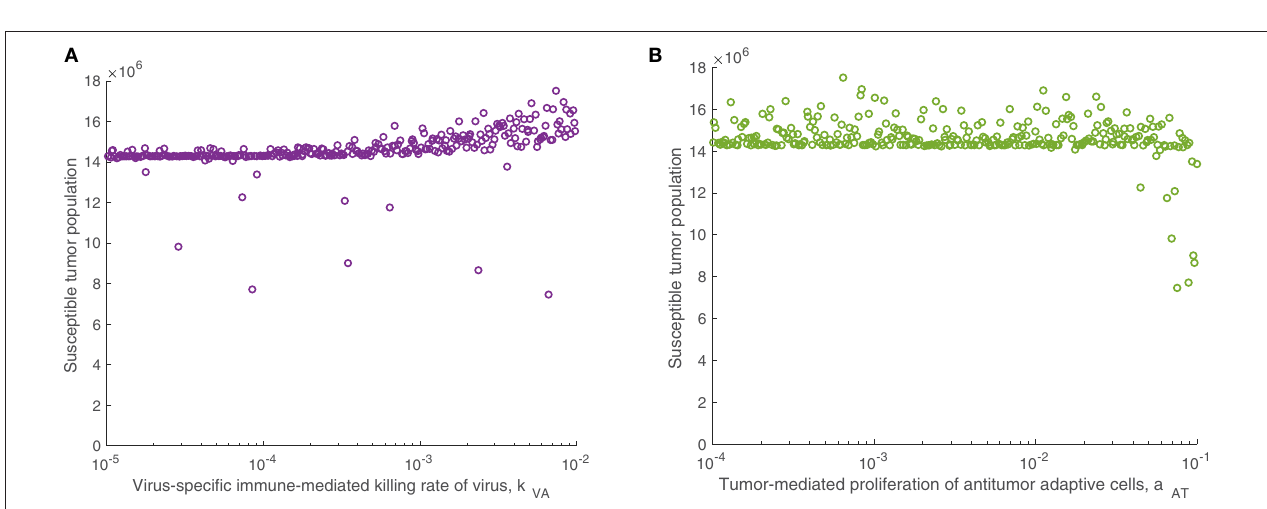
FIGURE 4 | Tumor size in innate immune sensitivity analysis. The tumor size (A) as a function of k VZ , the killing rate of the virus by innate immune cells, and (B) as a function of s ZR , the source of innate immune cells. We use t = 300 h as the endpoint for the innate sensitivity analysis. The PRCC between k VZ and the susceptible tumor population is P ( k VZ ,300) = 0.6591, and between s ZR and the susceptible tumor population is P ( s ZR ,300) = 0.3241.